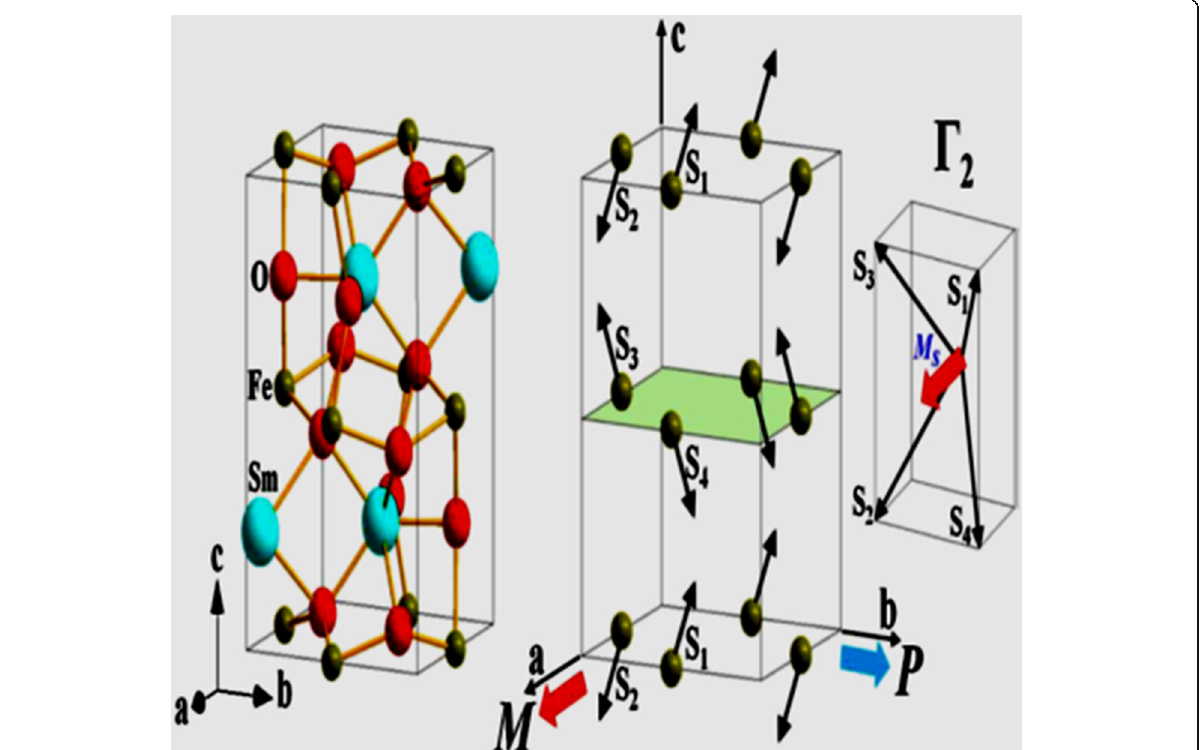
Fig. 7 Crystal structure and magnetic spectra of orthorhombic SmFeO 3 . Adapted from Scoot et al. [44]